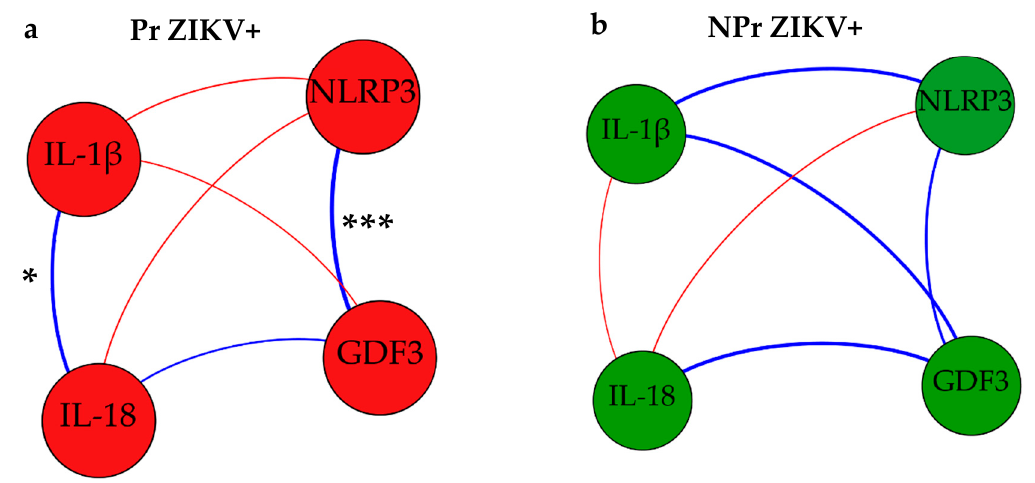
Figure 3. Correlation analysis between NLRP3 and GDF3 in ZIKV-infected groups. ( a ) Strong positive correlation (r = 0.91; p < 0.0001) in the Pr ZIKV+ group; ( b ) moderate positive correlation (r = 0.64; p = 0.014) in the NPr ZIKV+ group ( b ). The Pearson’s test was applied to perform correlation analysis. r > +0.7 refers to strong positive correlation.